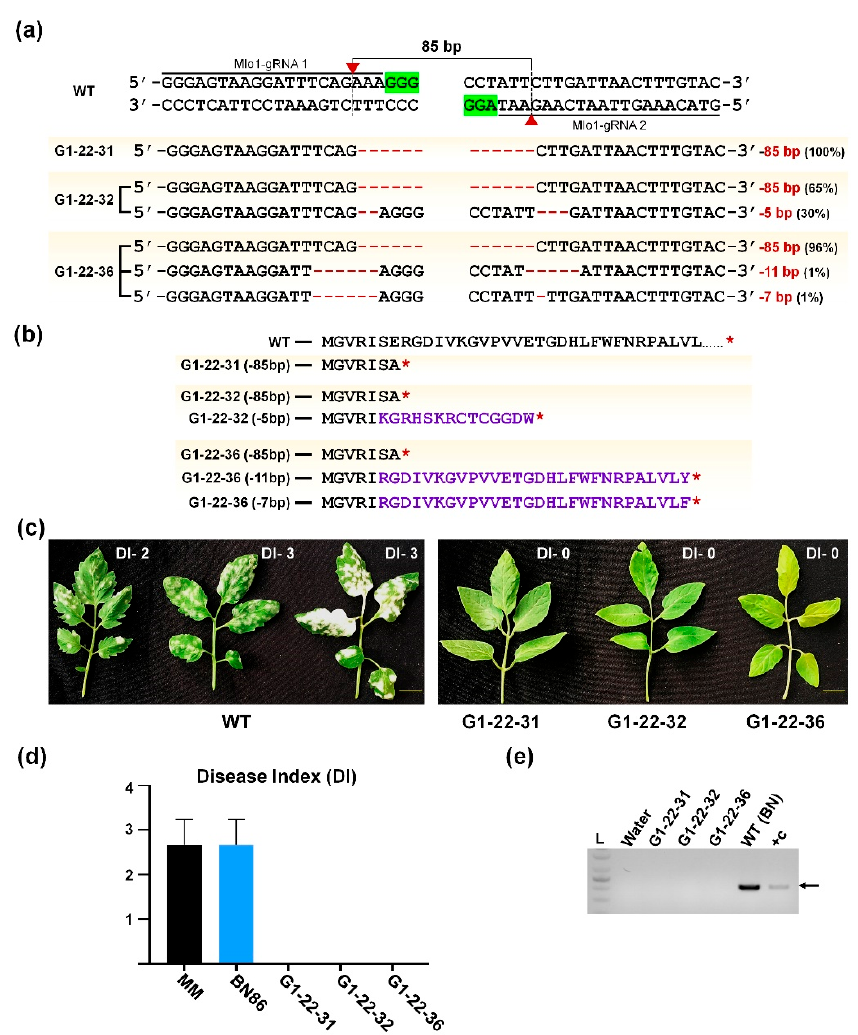
Figure 6. Characterization of CRISPR/Cas9-mediated SlMlo1 genome-edited tomato lines for powdery mildew resistance. ( a ) Indel patterns of three SlMlo1 -knockout plants showing the homozygous (G1-22-31), biallelic (G1-22-32), and chimeric (G1-22-36) genotype. The knockout efficiency (%) of individual lines evaluated using the ICE tool. Red dash indicates the deleted nucleotides; ( b ) Comparison of amino acid sequence between wild-type (WT) MLO1 protein and truncated region resulting from knockout alleles. Stop codon in red star symbol and altered amino acids in blue was indicated; ( c ) Analysis of SlMlo1 -knockout mutant lines tested for resistance against powdery mildew-causing fungus Oidium neolycopersici . The phenotype of the mutant plants evaluated at 21 days post-infection (DPI). Referring to visual fungal growth symptoms, we calculated the disease index; ( d ) Powdery mildew disease index was calculated with WT (BN-86 and Moneymaker (MM)) and G1 SlMlo1 mutant lines (G1-22-31, G1-22-32, G1-22-36). Error bars represent SE (three biological replicates); ( e ) Detection of O. neolycopersici by PCR method using strain-specific 16S ribosomal RNA (rRNA) primers. Non-infected plants used as mock control; fungal DNA used for PCR as a positive control.